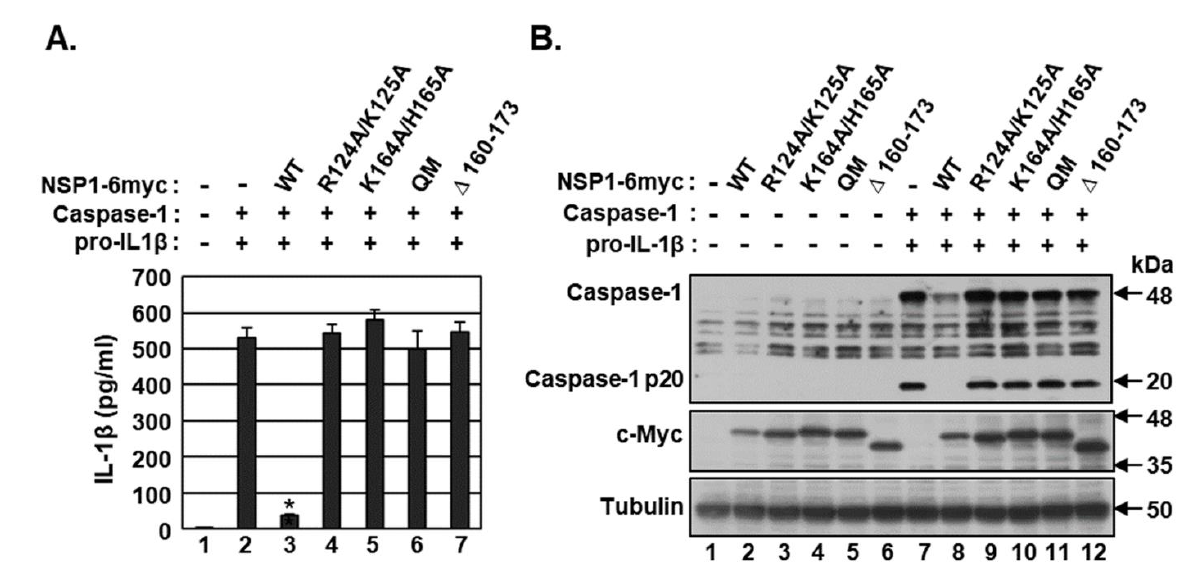
Figure 2. Determination of the amino acid residues of NSP1 critical for caspase-1 inhibition. (A and B) HEK 293T cells were co-transfected with vectors expressing caspase-1 and pro-IL-1β plus either pEF1α-DEST or pEF1α-DEST expressing c-Myc-tagged NSP1 wild type (WT) or NSP1 containing the mutations R124A/K125A, K164A/H165A, and both R124A/K125A and K164A/H165A (quadruple mutant (QM)) and a deletion of amino acids 160–173 (∆ 160–173). After 24 h, ( A ) the concentrations of mature IL-1β secreted in culture supernatants were measured by ELISA, and ( B ) levels of caspase-1 and NSP1 (c-Myc) proteins and the cleavage of caspase-1 into its p20 subunit were determined by Western blotting. ELISA data shown are representative of three independent experiments. * p < 0.001 by unpaired two-tailed Student’s t -tests.